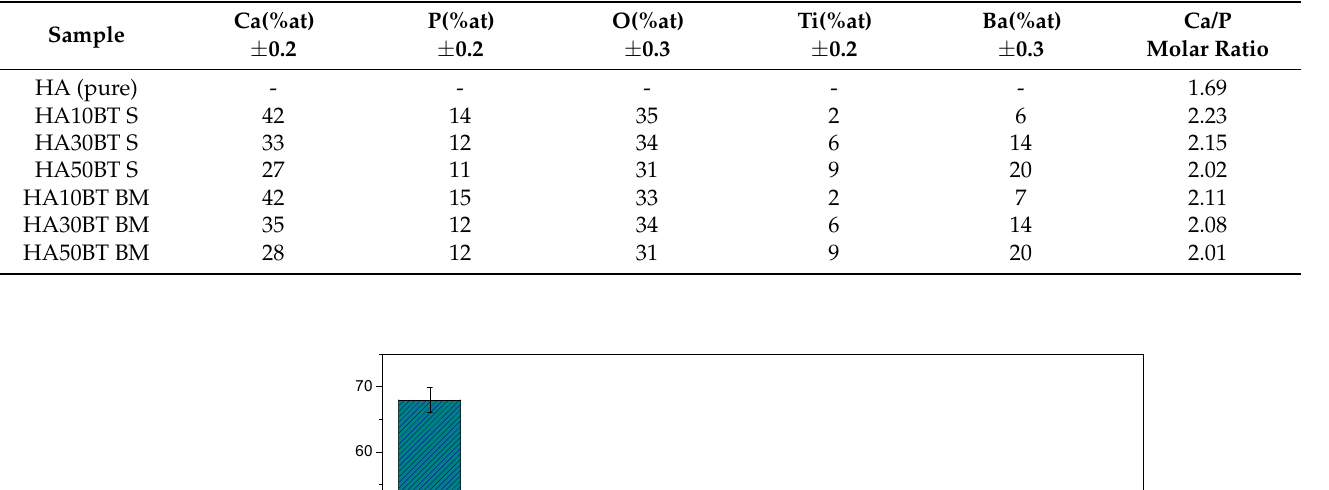
Table 3. Semiquantitative composition of HA/BT coatings measured by EDS.